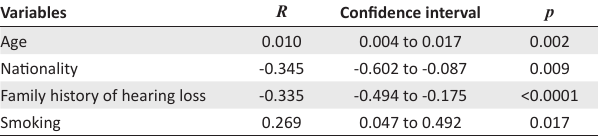
TABLE 5: Results of the true or false questionnaire score, based on multivariate analyses. Variables R Confidence interval